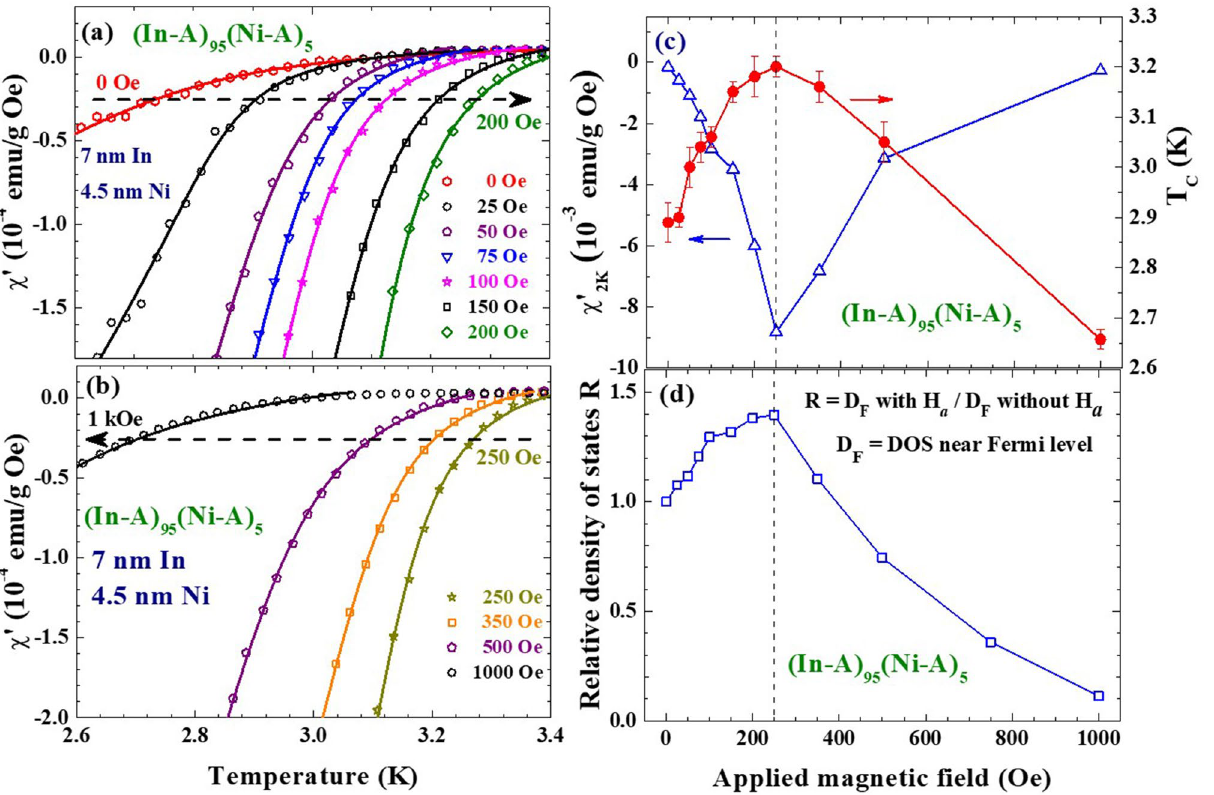
Figure 5. ( a , b ) Effects of the applied magnetic field on the χ ′ (T) curves of (In-A) 95 (Ni-A) 5 nanoparticle assembly, revealing alterations of T C as the applied magnetic field is changed. The solid curves indicate the results of the fits of the data to Scalapino’s expression for superconducting screening. ( c ) Variations of the value of χ ′ at 2 K (open triangles) and T C (filled circles) with the applied magnetic field of (In-A) 95 (Ni-A) 5 nanoparticle assembly, revealing a critical magnetic field for maximum T C and diamagnetic response χ ′ 2 K . ( d ) Variation of the relative density of states near the Fermi level R with an applied magnetic field of (In-A) 95 (Ni-A) 5 nanoparticle assembly, revealing a critical magnetic field for maximum